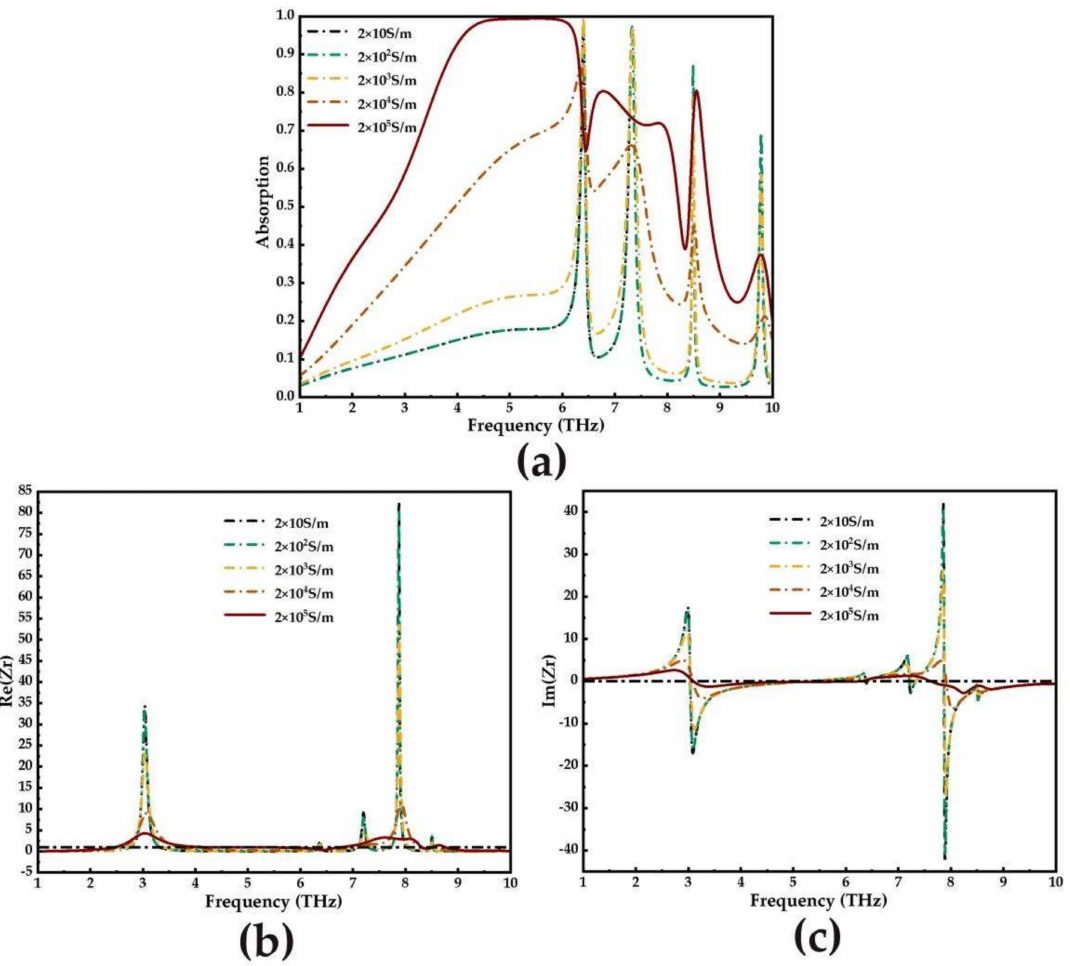
Figure 5. ( a ) Effect of different conductivity on absorption spectra during phase transition of VO 2 ; ( b ) real parts and ( c ) imaginary parts of the relative impedance ( Zr ) with different conductivities of VO 2